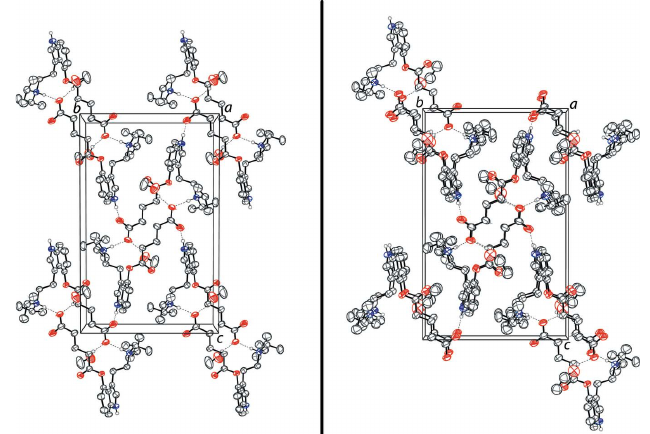
Figure 3 The crystal packing of the methanol solvate (left) and the ethanol solvate (right) of 4-glutarato- N , N -diisopropyltryptamine, both shown along the a -axis. Hydrogen bonds are shown as dashed lines. H atoms not involved in hydrogen bonding are omitted for